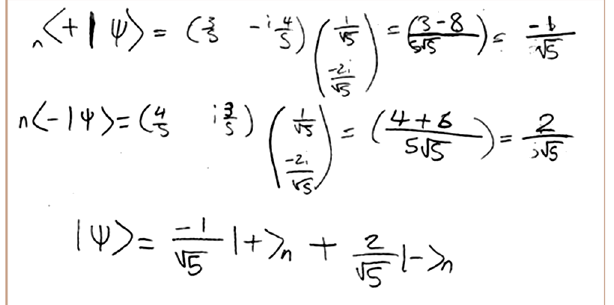
FIG. 6. Student solution to a standard change-of-basis problem. This student uses the projection method by taking the inner products of the state with the new basis vectors. The short calculation correctly and efficiently provides the coefficients in the new basis representation.